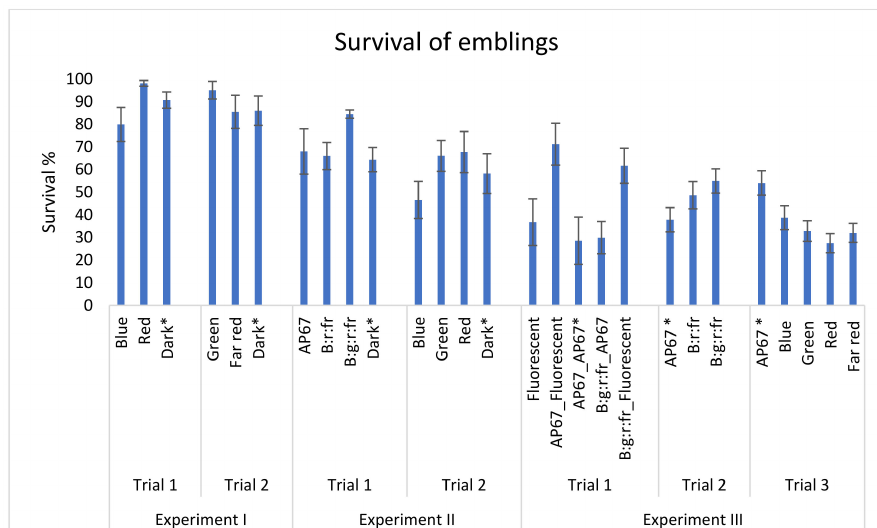
Figure 6. Survival percentages of emblings after six weeks’ growth (or four weeks in Experiment III Trial 1) in growth containers. In Experiment I ET was grown under the light spectra shown in the figure, embryos were matured in the dark and germinated under AP67 spectrum light. In Experiment II embryos from ET grown in the dark were matured for the last 26 days under the light spectra shown in the figure, and then germinated under AP67 spectrum light. In Experiment III embryos from ET grown and matured in the dark were germinated in the spectra shown in the figure. The emblings were kept in growth containers under AP67 spectrum light except in Experiment III Trial 1 where they were kept under AP67 light and fluorescent lights in a climatic chamber. The treatments marked with an asterisk (*) in the different experiments represent the same control treatment in which the ET was proliferated, and the somatic embryos matured in the dark, while the embryos germinated and grew under AP67 spectrum light. The differences in survival of emblings between SE lines are illustrated in Supplementary Figures S5 and S6. The results from logistic regression analysis used to examine the differences in survival of the emblings (0 = dead, 1 = alive) are in Supplementary Tables